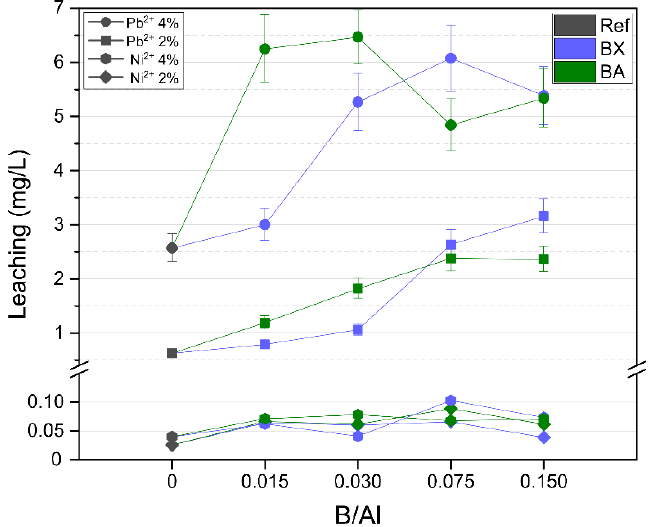
Figure 12. Heavy metal leaching from the geopolymers. Table 3. Heavy metal immobilization in the